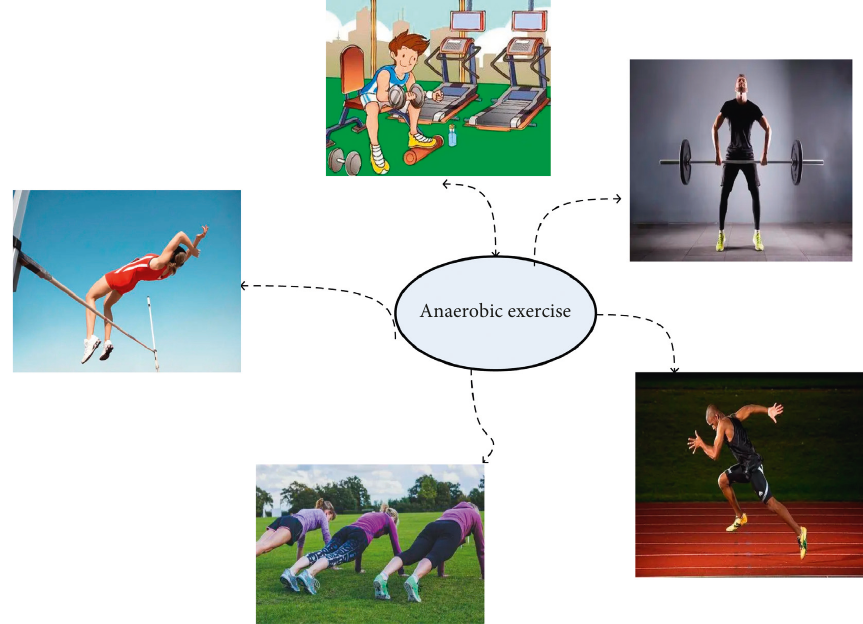
Figure 8: Some common anaerobic exercise methods. Table 2: Brief list of physical health